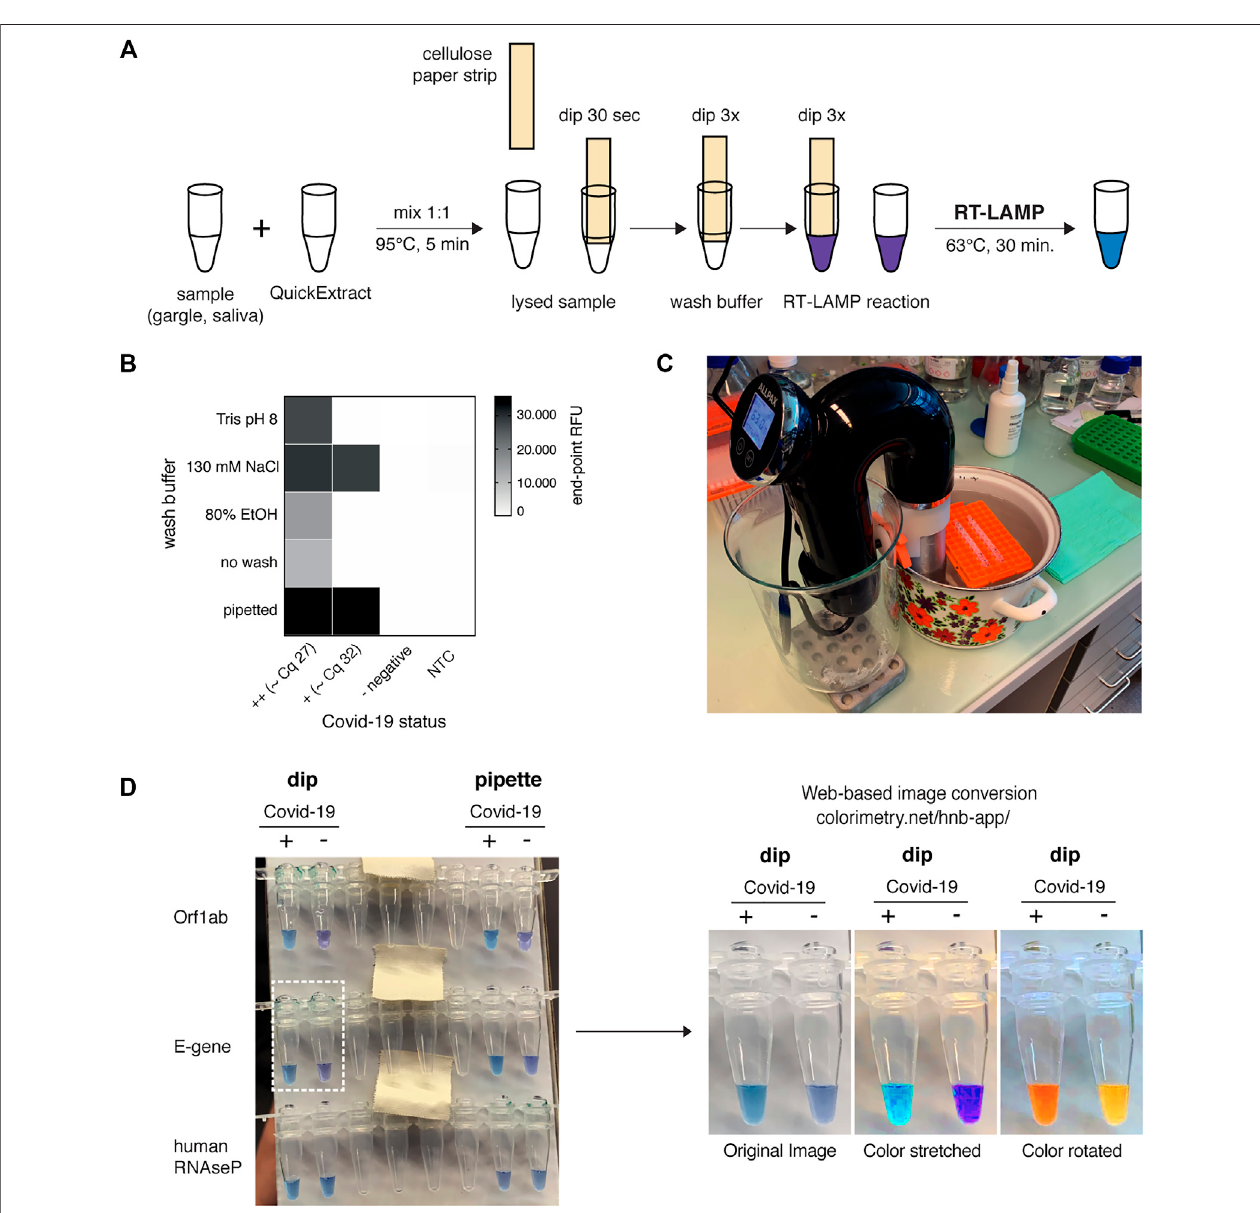
FIGURE5| HomeDip-LAMPenablesSARS-CoV-2detectioninlow-resourceandhomesettings. (A) SchematicdepictingtheHomeDip-LAMPwork fl ow.Samples aremixed1:1withQuickExtractlysisbufferand inactivated at95 ° Cfor5 min.Cellulosepaperdipsticksareloadedbydippingintothecrudesamplefor30 s.Afterabrief washing step (3x dipping into wash buffer), RNA is released into pre-distributed RT-LAMP reaction mixes by 3x dipping. RT-LAMP reactions are performed in a water bath at 63 ° C and read out after 35 min. (B) In fl uence of different wash conditions on SARS-CoV-2 detection using RT-LAMP with paper dipstick sample transfer. Heatmap showing end-point relative fl uorescence units (RFUs) at 30 min of RT-LAMP reactions after transferring 2 µl of high titer (++, Cq ~27), medium-to-low titer (+, Cq ~32) or negative COVID-19 patient samples in QuickExtract into 8 µl of RT-LAMP reaction mix using cellulose paper dipsticks. Dipsticks were washed in between in indicated solutionsor transferred without washing. Asample series where 2 µl were transferred by pipetting ( “ pipette ” ) is shown alongside (NTC = no target control). (C) ImageshowingthewaterbathsetupwithaSousVideheater(black)forHomeDip-LAMP. Reactiontubeswerekept uprightandsubmergedusing fl oatingplasticpipette tip racks (orange). (D) Detection of SARS-CoV-2 using HomeDip-LAMP. Left image shows true color readout (HNB dye) of HomeDip-LAMP (left 2 tubes) and pipetted LAMP(right2tubes)reactionsusingaCOVID-19-positive(+)and-negative( − )patientsampleinQuickExtractasinput(35 minend-point;waterbathincubationat63 ° C). Amplicons are indicated to the left; the human RNAseP amplicon served as positive control. The images to the right show color-manipulations via the web-app (https:// colorimetry.net/hnb-app/) of the two PCR tubes highlighted on the left for easier readout.